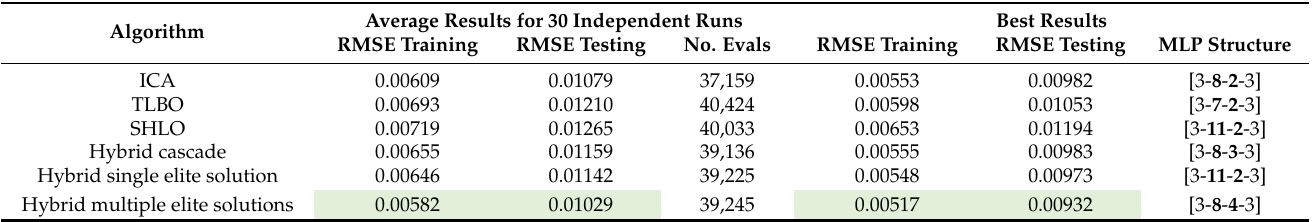
Table 2. Simulation results obtained on the MMA data set with the individual optimizers and the ensemble